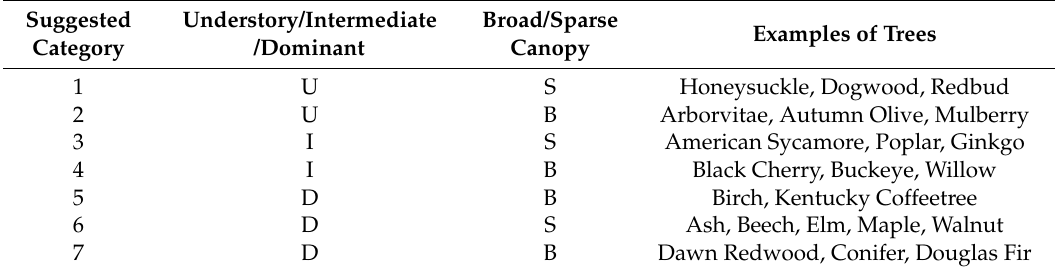
Table 1. The suggested tree categories based on the degree of the resistance to air flow based on tree stature (understory, intermediate, or dominant) and crown density (broad or sparse). Suggested Understory/Intermediate Broad/Sparse Examples of Category /Dominant Canopy